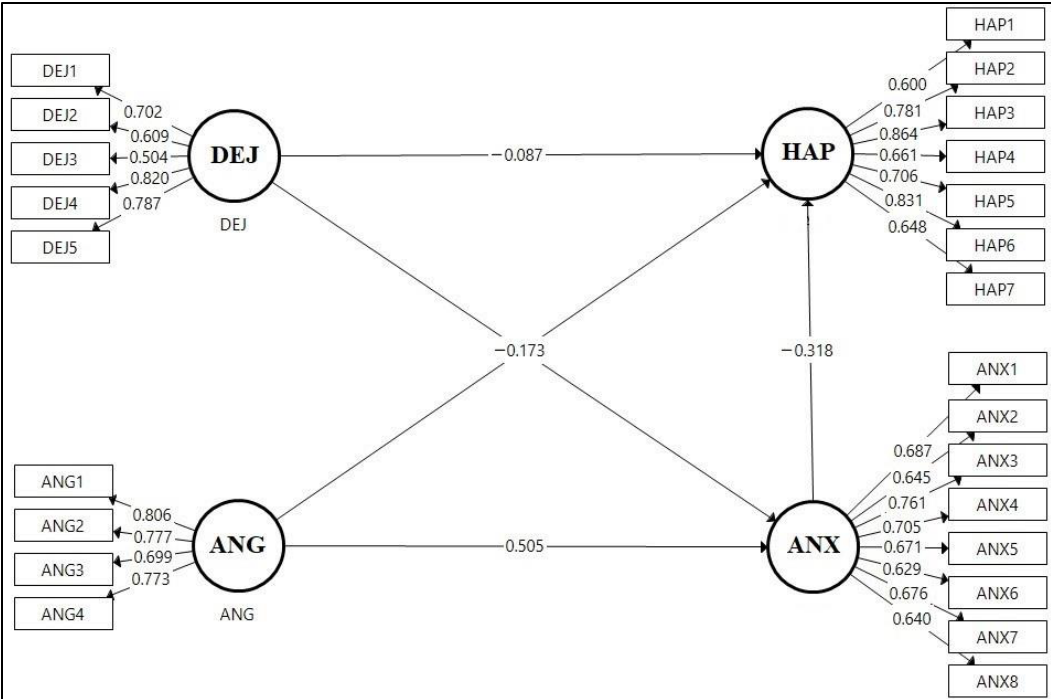
Figure 2. An initial structural model with outer loading. Int. J. Environ. Res. Public Health 2020 , 17 , x